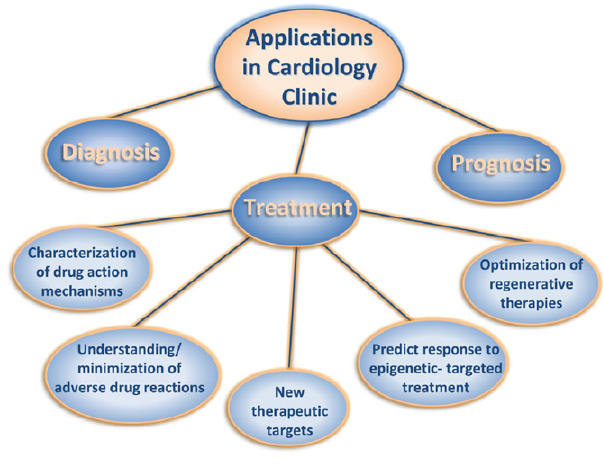
Figure 8. Applications of epigenetics in the cardiology clinic including diagnosis, prognosis and